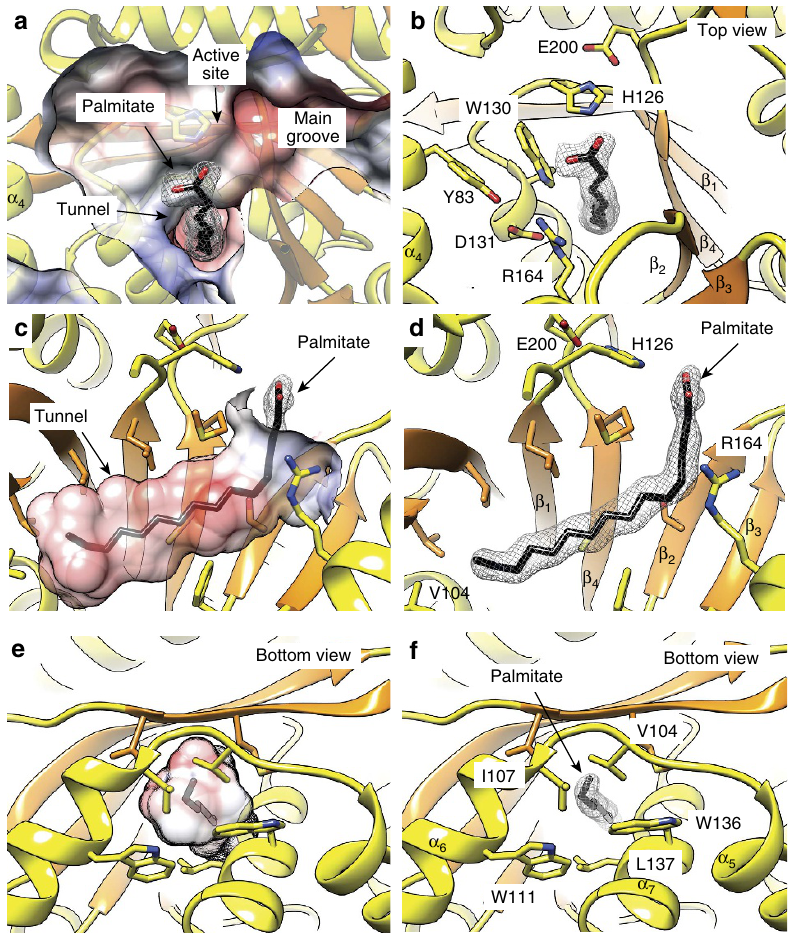
Figure 3 | The palmitate binding site of PatA. ( a – d ) Four views of PatA–C16-1 crystal structure showing the palmitate chain deeply buried into the hydrophobic tunnel. ( e , f ) Two views of PatA showing the cap which closes the bottom of the hydrophobic tunnel. The 2mFo-DFc electron density map countered at 1 s for the palmitate ligand is